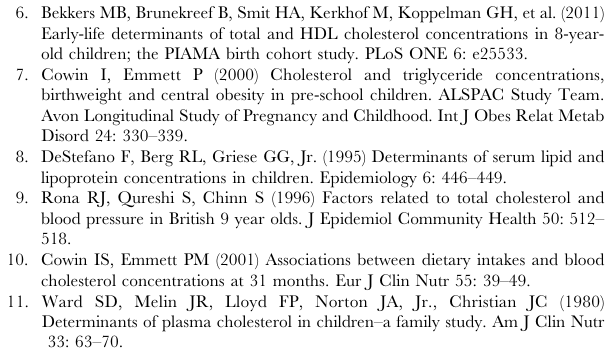
Table S1 Comparison of the percentages of explained variance of total cholesterol (TC), HDL cholesterol (HDLc), and non-HDL cholesterol (nHDLc) by genetic and non-genetic